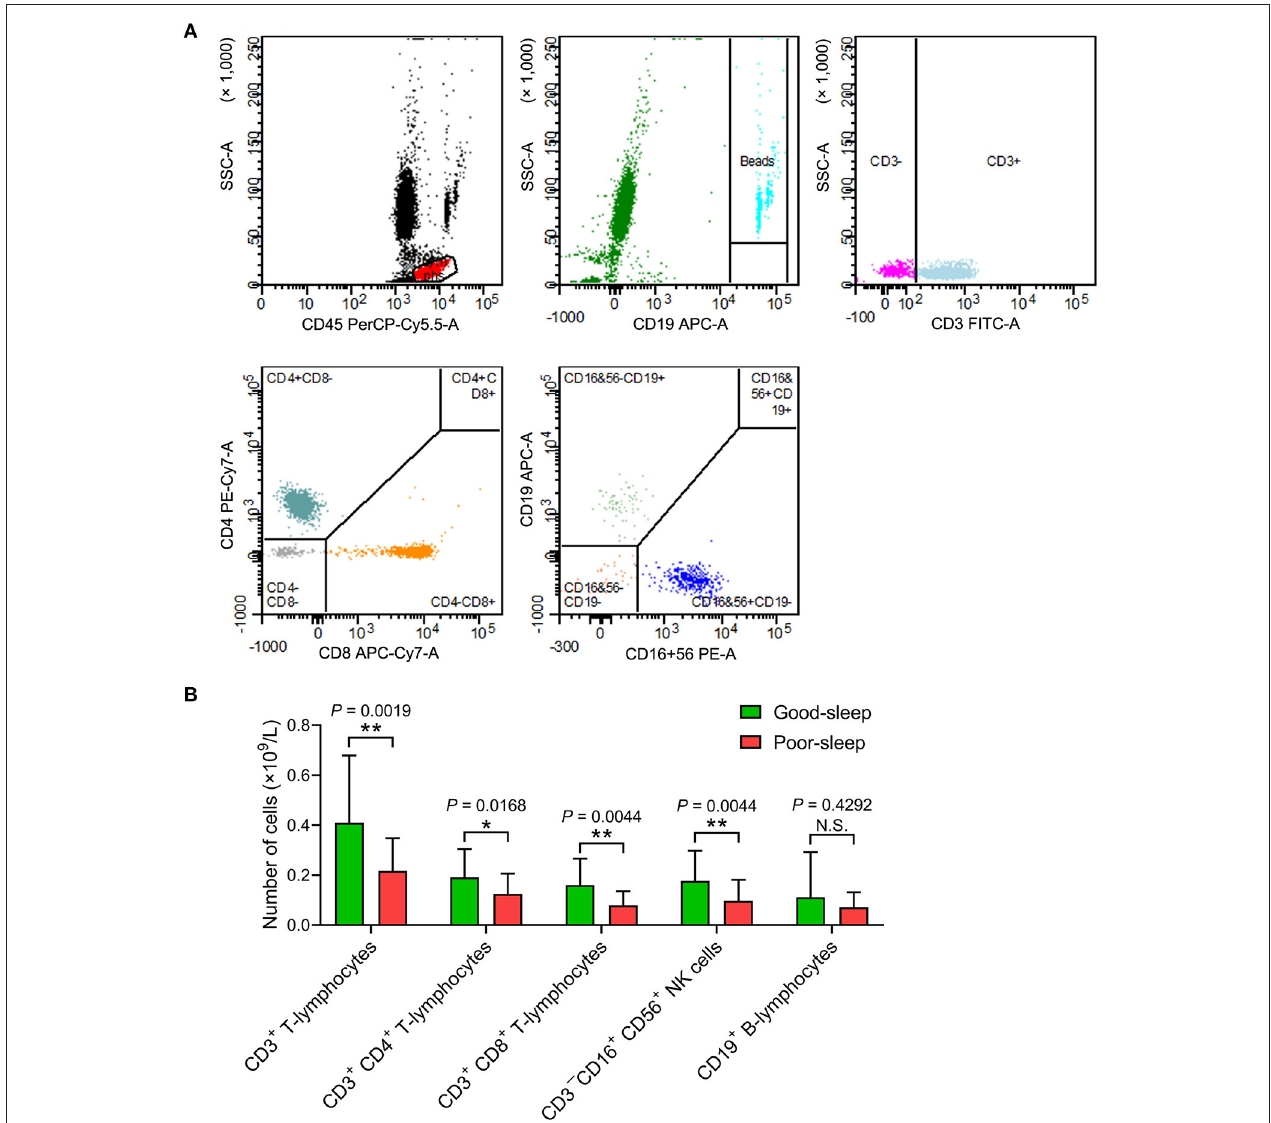
FIGURE 3 | Effects of post-septic sleep deprivation on the number of lymphocyte subsets. (A,B) Flow cytometry analysis of CD3 + T-lymphocytes, CD3 + CD4 + T-lymphocytes, CD3 + CD8 + T-lymphocytes, CD3 − CD16 + CD56 + NK cells, and CD19 + B-lymphocytes in peripheral blood on day 5 after inclusion. Data are shown as mean ± SD. * P < 0.05 and ** P < 0.01. N.S., not significant; NK cells, natural killer cells.